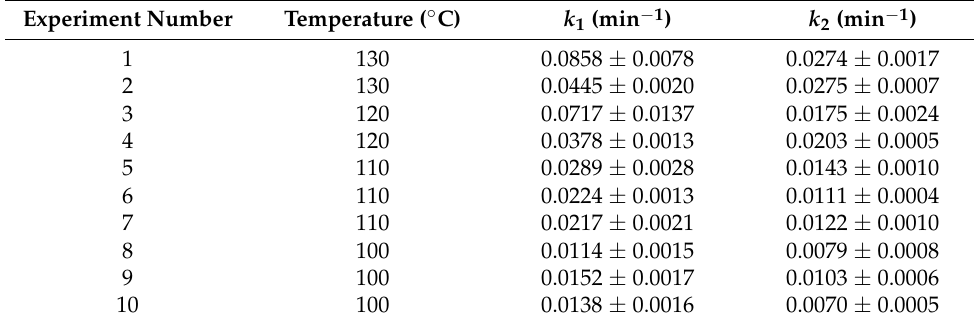
Figure 3. Reaction profiles obtained from 1 H NMR data for methanolysis fitted in SigmaPlot. ( A ) 130 °C R 2 = 0.9943 ( B ) 120 °C R 2 = 0.9954. Table 5. Rate coefficients for each experiment, catalysed by ZnAc and DMAP.